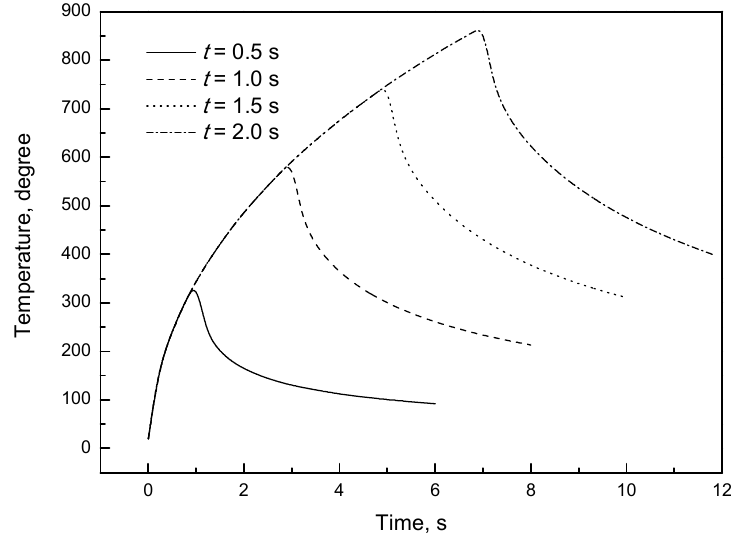
Figure 9. Variation of temperature with irradiation